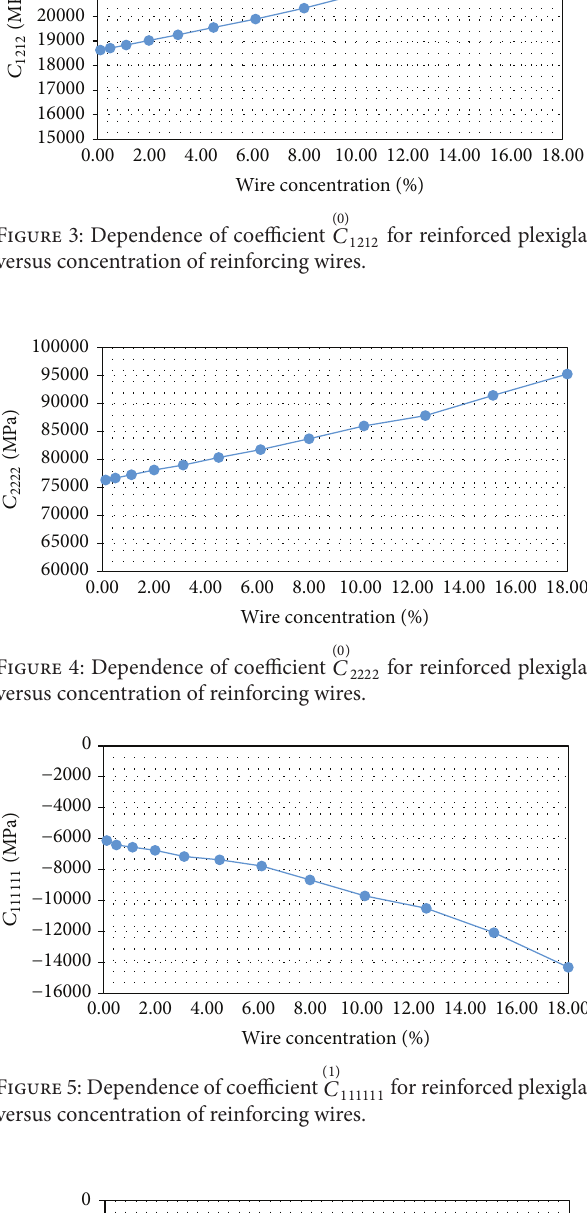
Figure 5: Dependence of coefficient versus concentration of reinforcing wires.